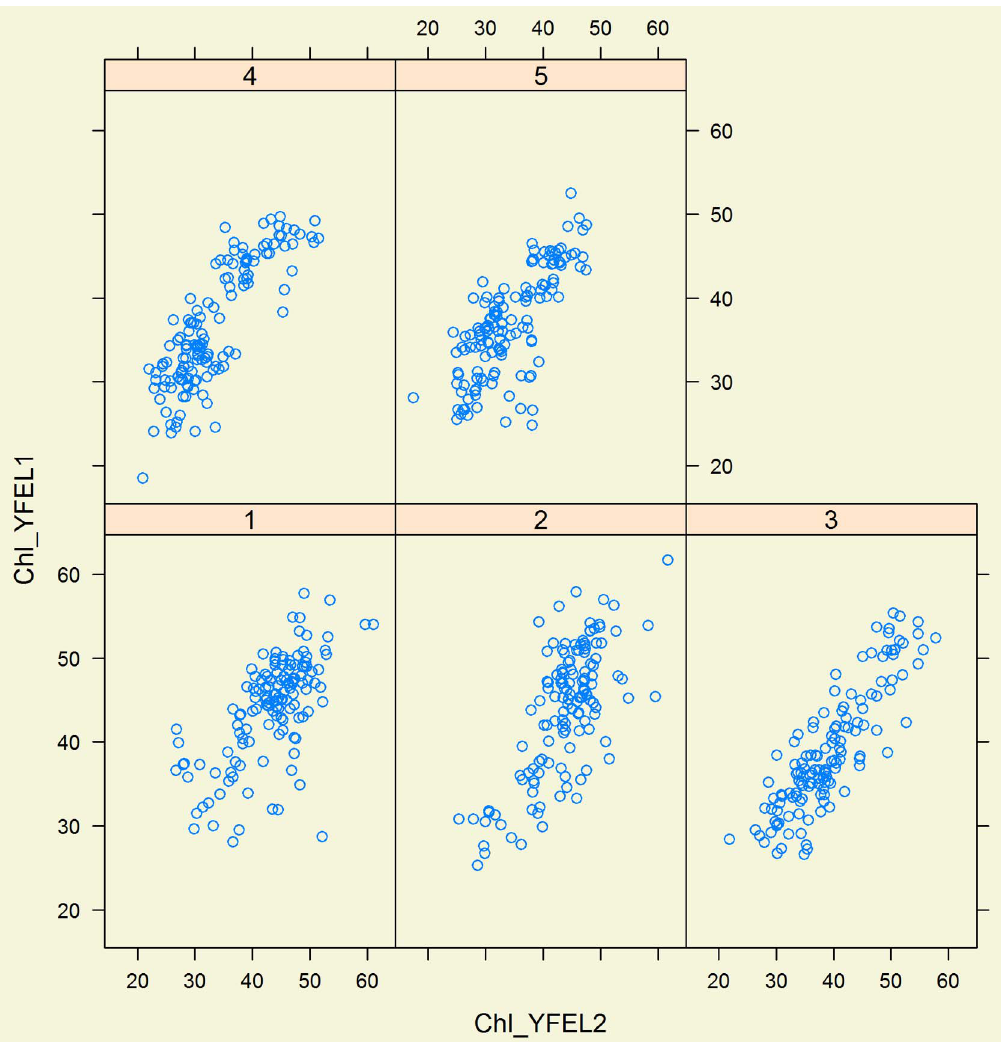
Figure 1. SPAD units (Chlorophyll) of first young fully expanded leaf (YFEL1) versus second young fully expanded leaf (YFEL2) for all five SPAD reading dates (1, 2, 3, 4 and 5) of experiment 1.